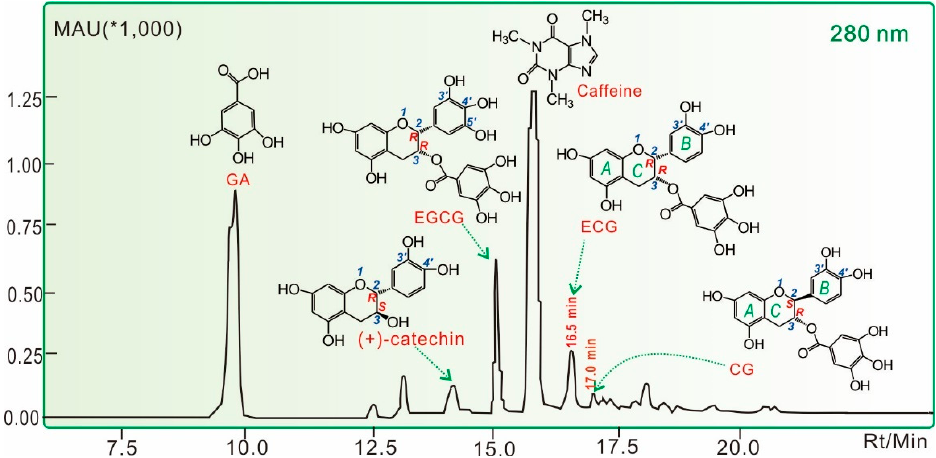
Figure 1. HPLC of LATT. GA , gallic acid; CG , ( − )-catechin gallate; ECG , ( − )-epicatechin gallate; EGCG , ( − )-epigallocatechin gallate. The determining wavelength was 280 nm; The longitudinal axis was the strength of absorbance. MAU, milli-absorbance unit; Rt, retention time; Min, minute.